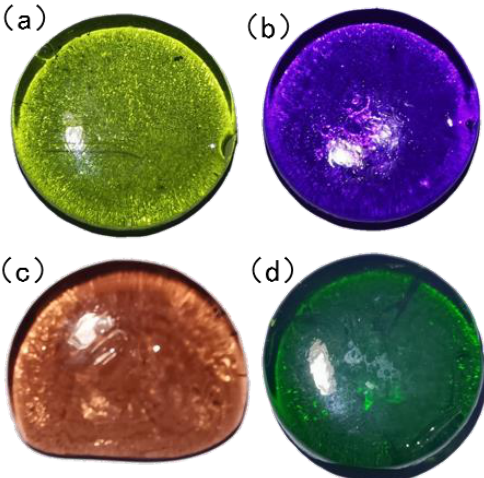
Figure 1. Imitation gemstone glass: ( a ) sample 1; ( b ) sample 2; ( c ) sample 3; ( d ) and sample 4.